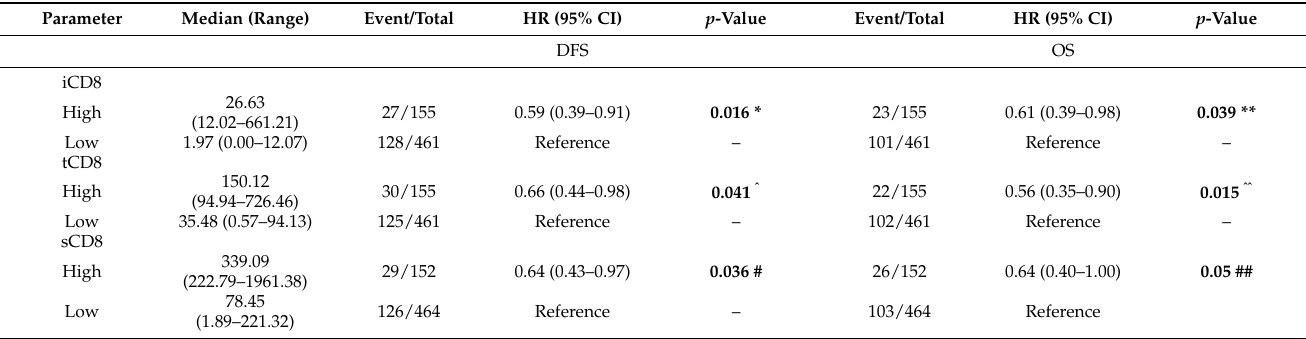
Figure 3. Disease-free survival (DFS) and overall survival (OS) based on iCD8 ( A , B ), sCD8 ( C , D ), and total CD8 ( E , F ) counts/mm 2 in the entire cohort of patients. Table 2. Results of Cox multivariate regression models for DFS and OS in the entire